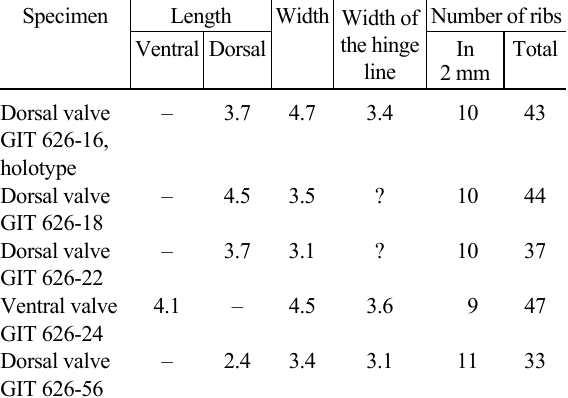
Table 1. Measurements (in mm) of Sigmelasma peepi sp.